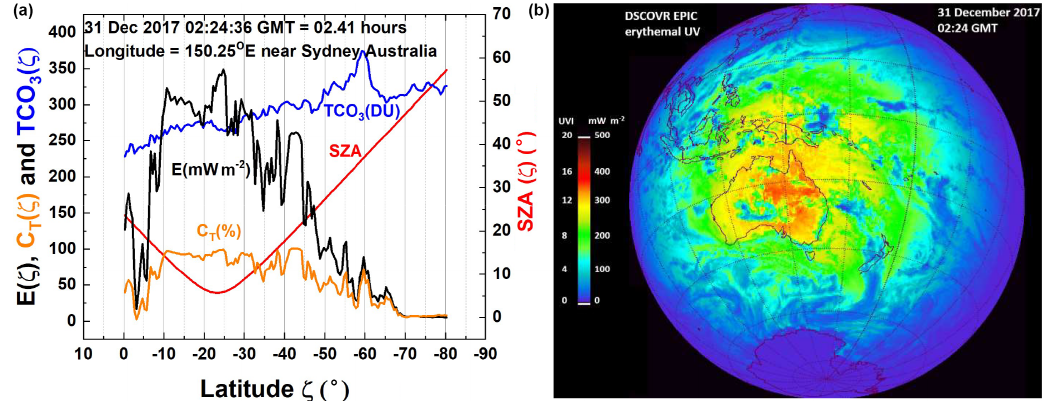
Figure 14. (a) Latitudinal distribution of E(ζ,ϕ,z,t) and its contributing factors, TCO 3 , C T , and SZA, for a line of longitude passing near Sydney, Australia. (b) Global distribution of E(ζ,ϕ) from DSCOVR EPIC data on 31 December 2017 02:24:36GMT. Figure map created with IDL ®